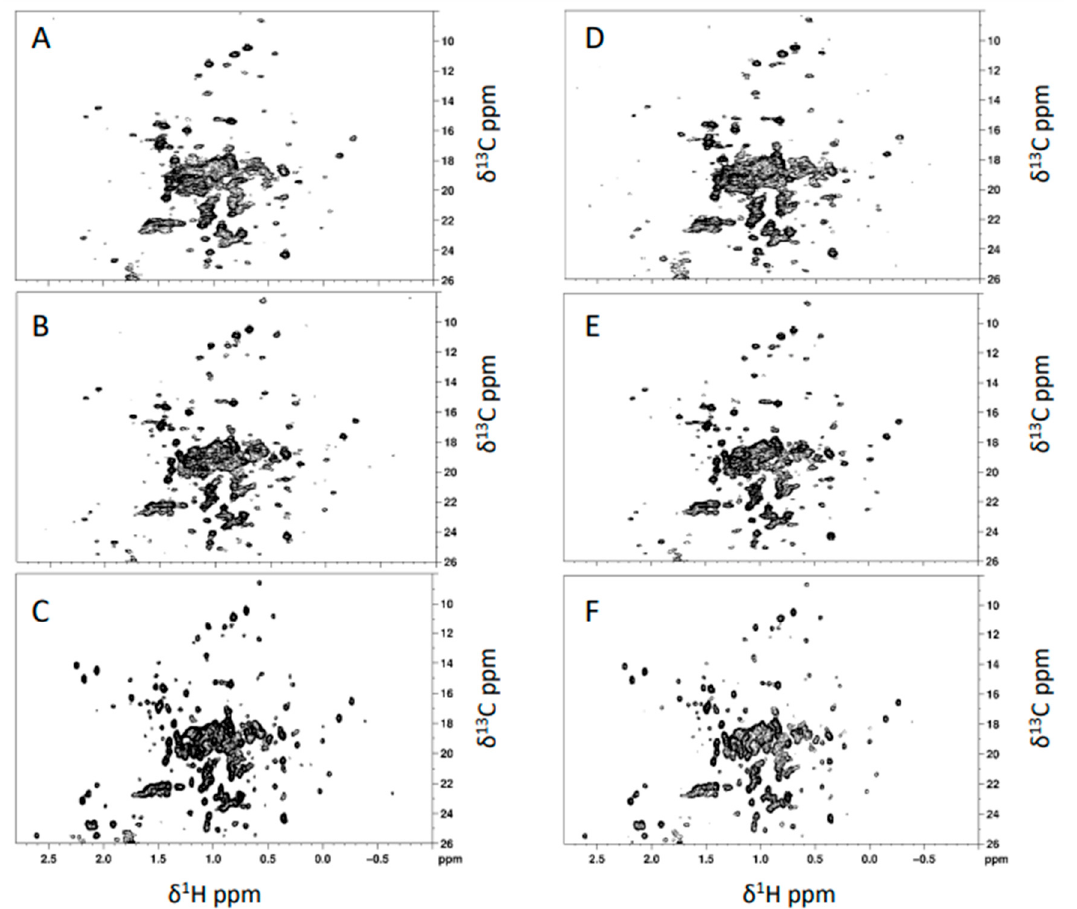
Figure 1. 1 H- 13 C ALSOFAST-HMQC spectra of batches 19G and 20G acquired with 700 ( A , B ), 900 ( C , D ), and 1200 MHz ( E , F ) spectrometers. Table 1. Average combined chemical shift